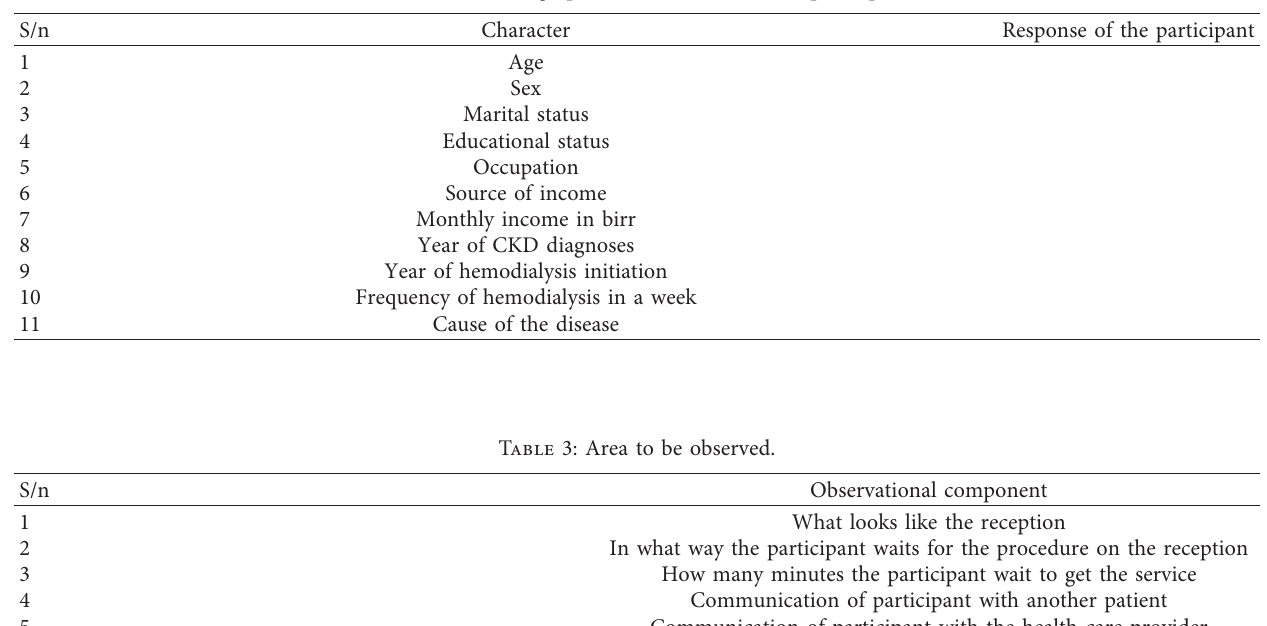
Table 2: Sociodemographic characteristics of the participants.